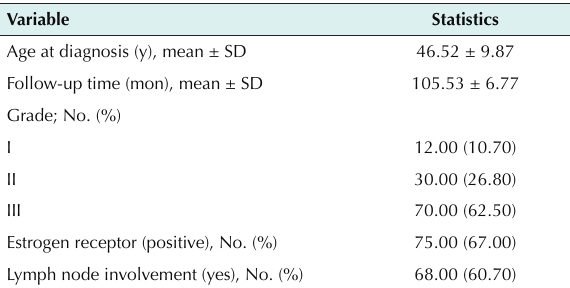
Table 1. Patient's Characteristics